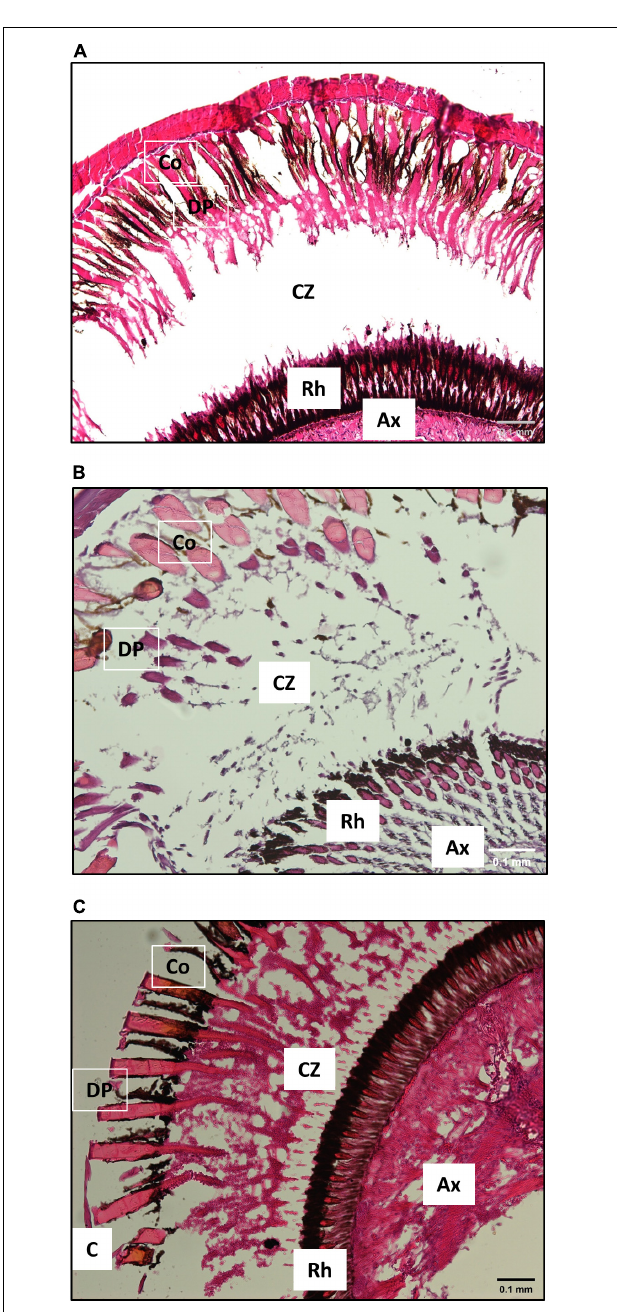
FIGURE 4 | Representative histological sections of slipper lobster eyes (10 × ). All three species had a clear zone between the rhabdoms and the distal pigment cone cell, a hallmark of superposition eyes. (A) S. squammosus, (B) I. novemdentatus and (C) P. japonicas . C: cornea, Co: cones, DP: distal pigment, CZ: clear zone, Rh: rhabdoms and Ax: axons. Scale bar represents 0.1 mm.